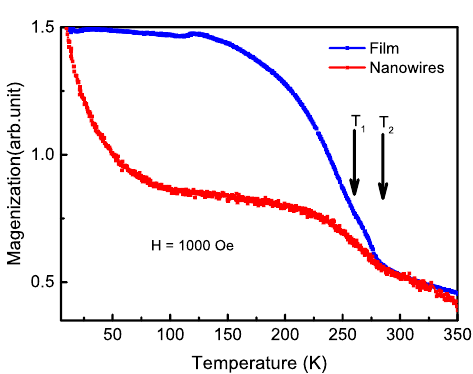
Figure 2. Comparison of the magnetization of film and nanowires. Arrows marked the two transitions near 260 K and 290 K. Both curves were measured at 1000